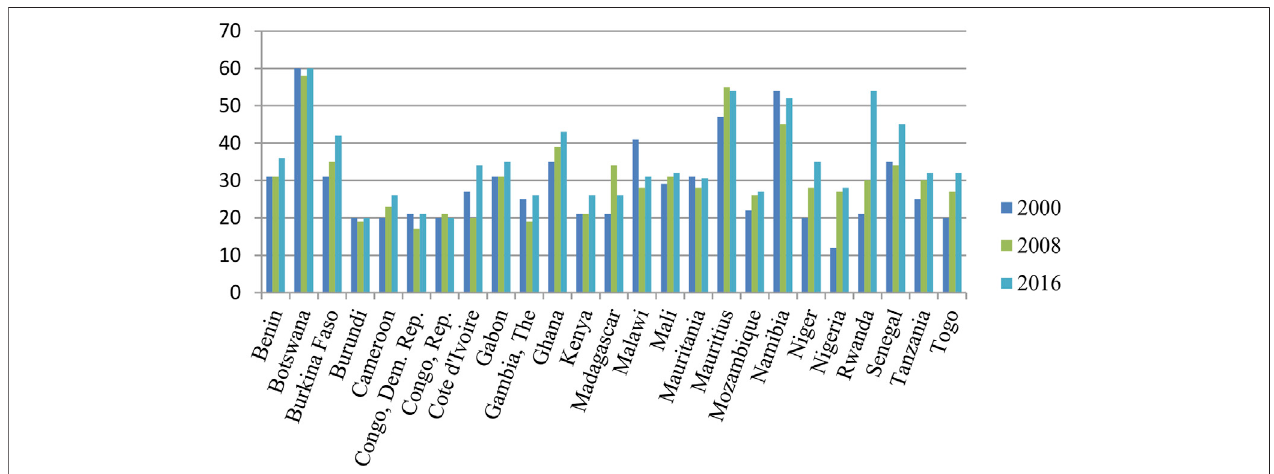
FIGURE 1 | Corruption perception index for sub-Saharan Africa (trend in different years). Source: Transparency International (2016).